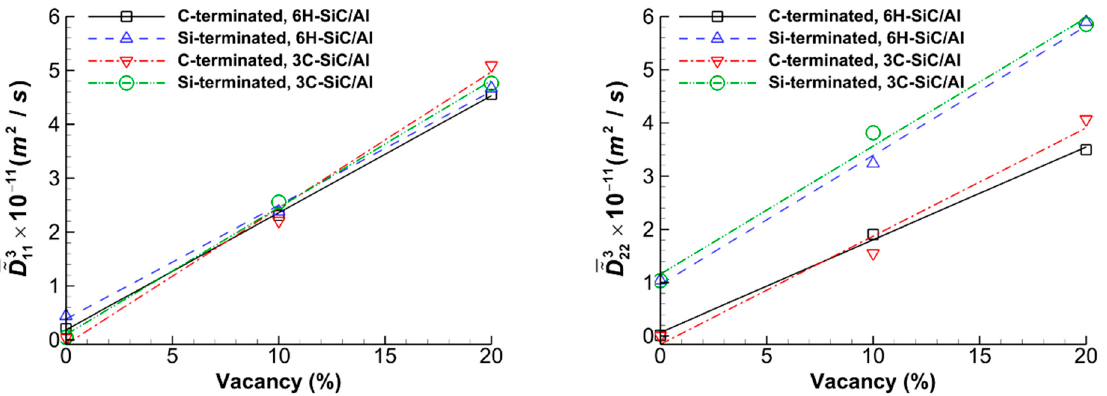
 3 3 3 D and  3 D versus the 11 22 11 and (cid:101) D 22 versus the